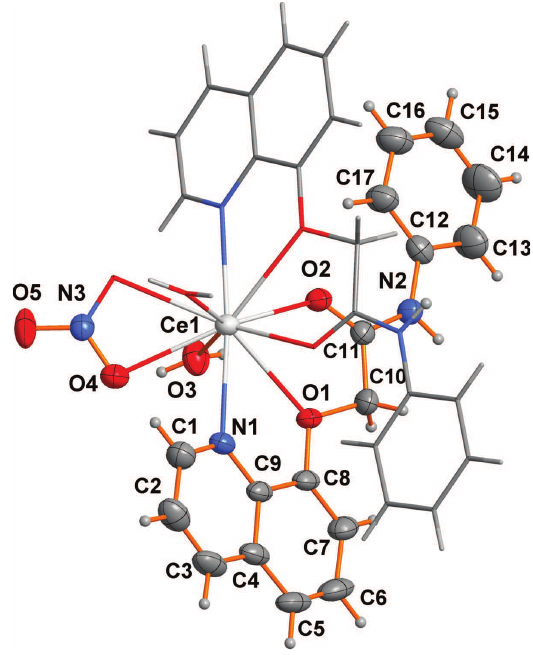
Table 1: Data collection and handling.